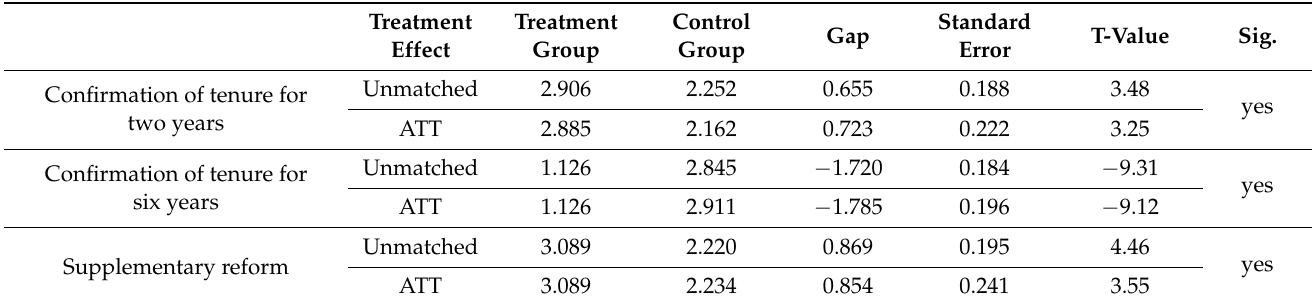
Table 4. Results of the treatment effect of forest tenure reform on farmers’